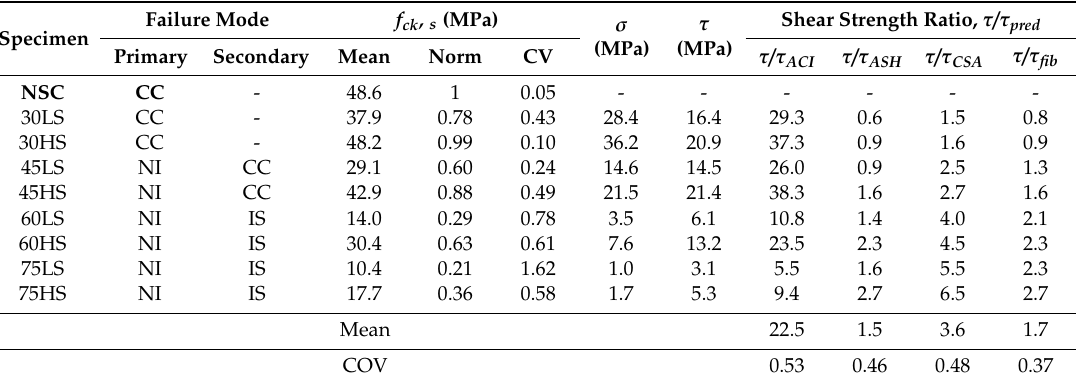
Table 7. Summary of slant shear test